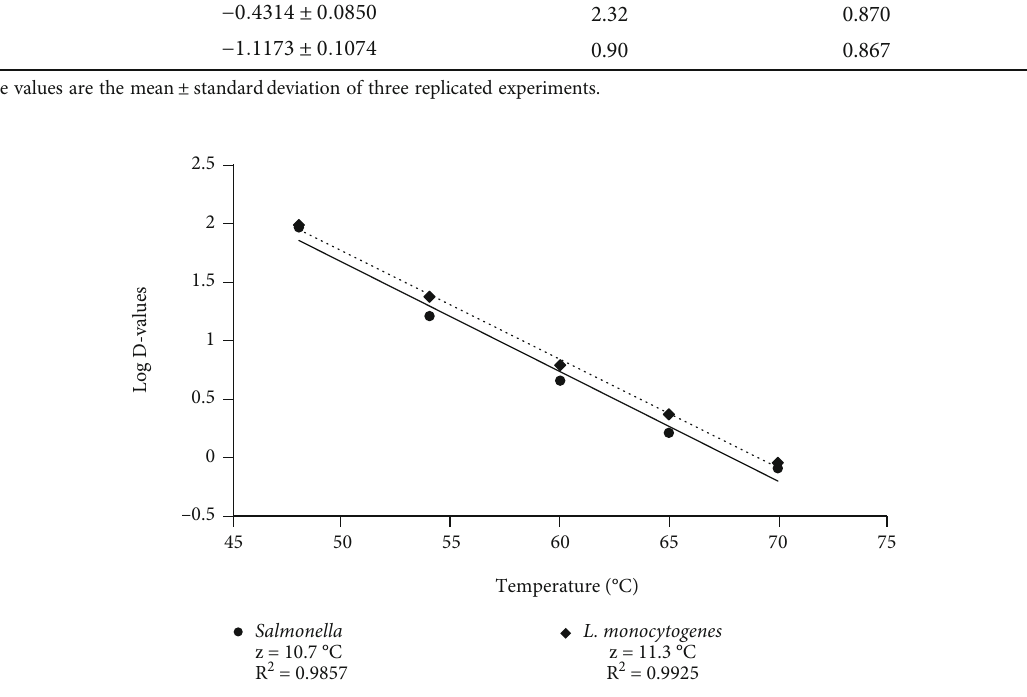
Figure 1: Thermal death time curve ( z value) for Salmonella enterica and Listeria monocytogenes for a temperature range of 48 to 70 ° C during heating of fresh curd. Each data point represents the mean of three replicated experiments at each temperature.